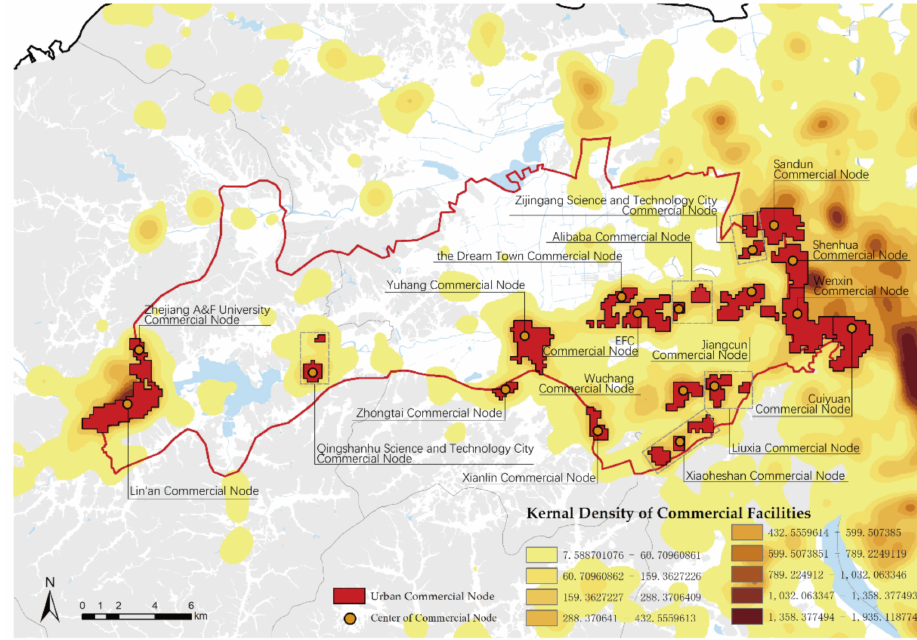
Figure 6. Spatial distribution of UCNs.